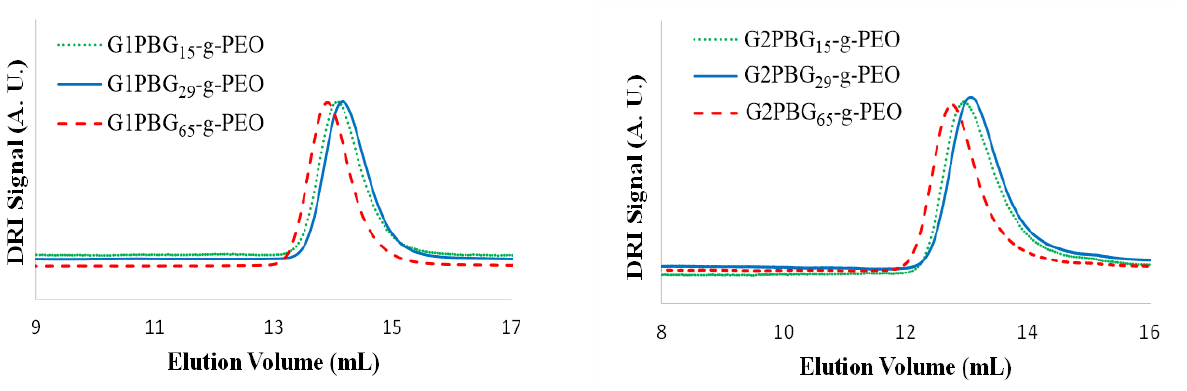
Figure 2. SEC traces for G1 ( left ) and G2 ( right ) arborescent copolymers.